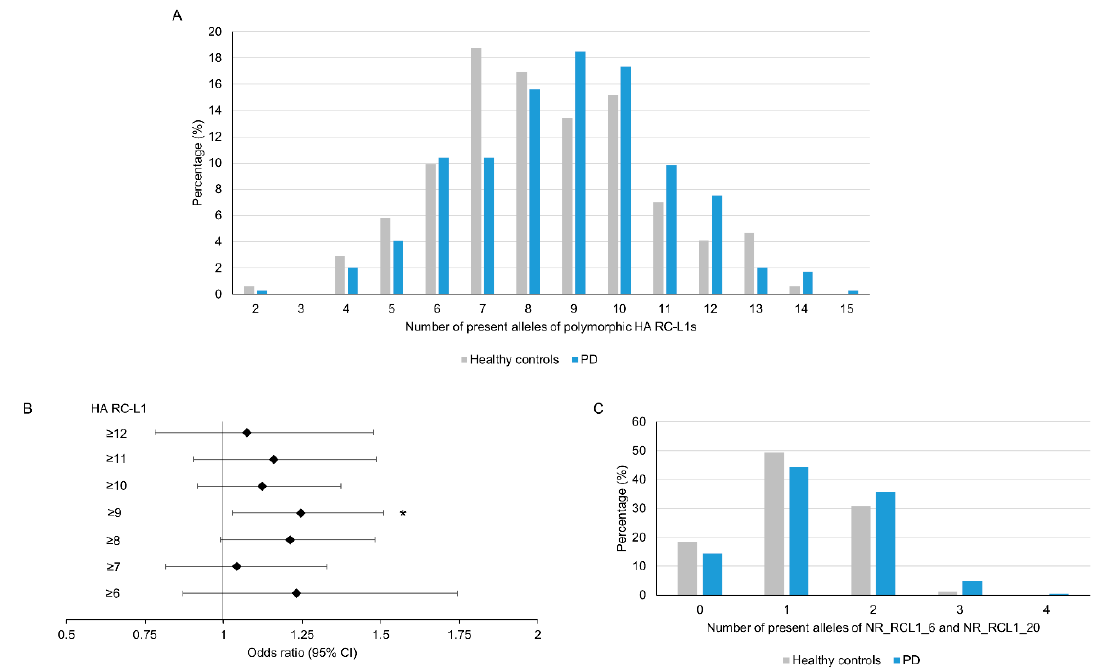
Figure 3. An increase in the number of highly active RC-L1s is significantly associated with Parkinson’s disease. In total, 22 reference and 50 non-reference RC-L1s were identified as polymorphic for their presence and 18 of these were classified as highly active (HA). The total number of alleles with an HA RC-L1 insertion present was calculated for each individual in which 16 of HA RC-L1 genotypes (2 present on X chromosome were excluded) were available. The number of alleles with an HA RC-L1 present ranged from 2 to 14 in the healthy controls and 2 to 15 in PD subjects. ( A ) A comparison of the percentage of healthy controls and PD subjects with defined numbers of HA RC-L1s present. ( B ) The forest plot represents the odds ratio of having PD based on an increasing number of the